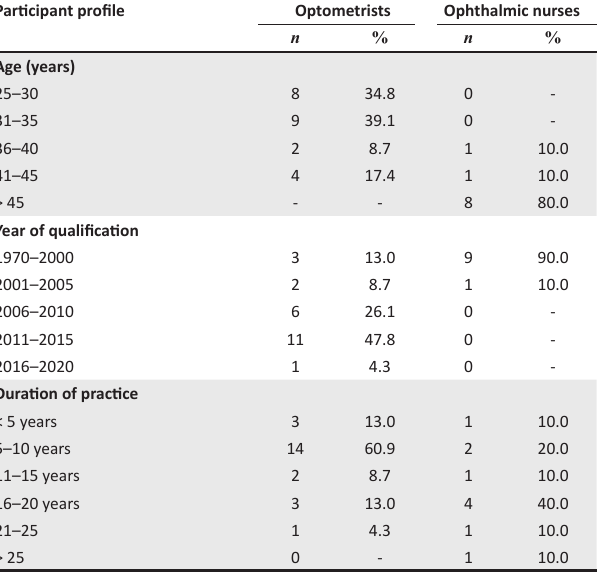
FIGURE 3: Percentage of self-reported competency level of medicals officers (general practitioners) in conducting examination procedures.